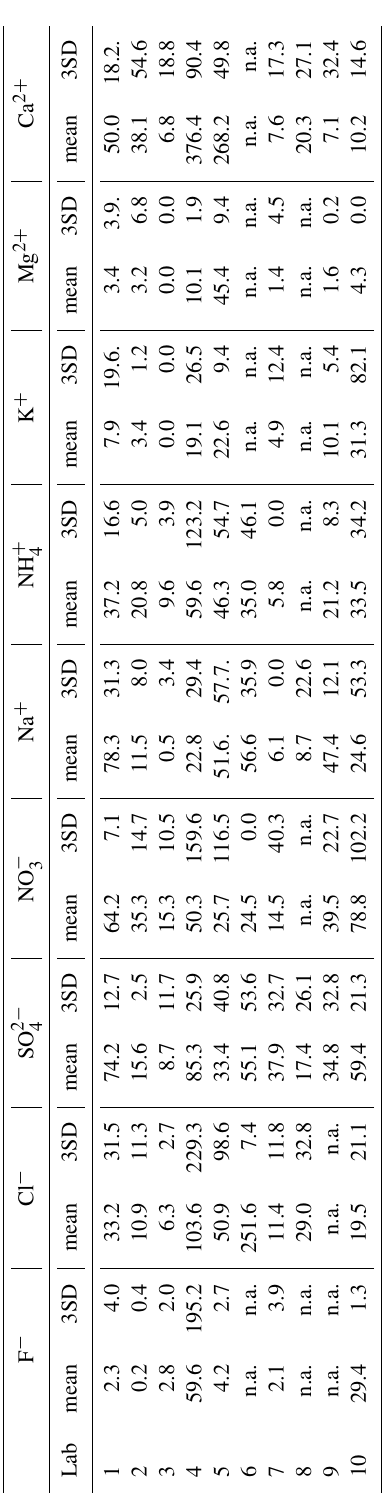
Fig. 2. The time series of IC and ACSM data at IAP and BUCT are plotted in Fig.